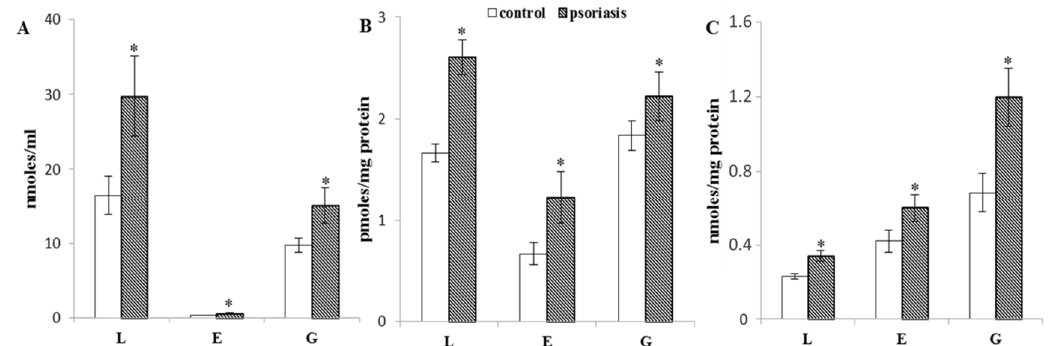
Figure 6. The level of 4-HNE ( A ), 4-HNE-protein adducts ( B ), and carbonylated proteins ( C ) in erythrocytes (E, n = 68), lymphocytes (L, n = 20), and granulocytes (G, n = 20) of psoriatic patients compared to healthy subjects (control) (E, n = 34, L, n = 10, and G, n = 10); ∗ —statistical significance at p < 0.05 vs. control.